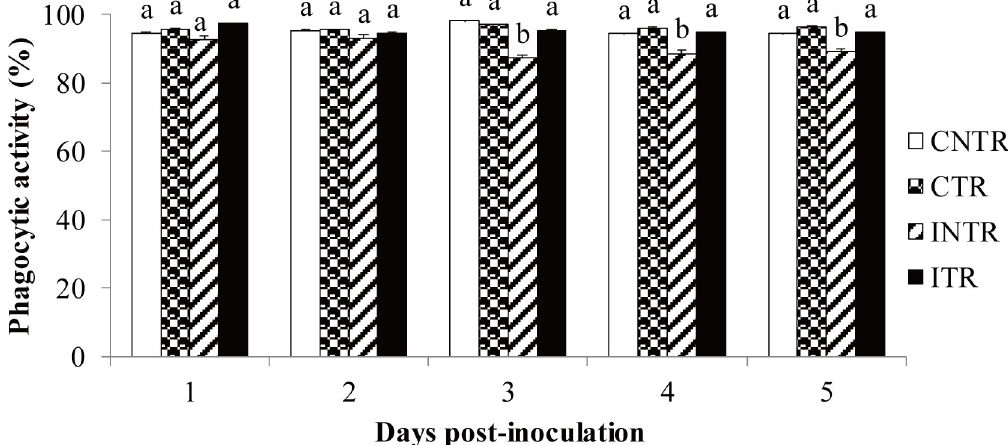
Fig 9. In vivo phagocytosis. In vivo phagocytic activity of Locusta migratoria manilensis inoculated with Beauveria bassiana (3 × 10 5 spores/5 th instar nymph) and injected with FITC-labelled silica beads at various days post-infection. CNTR means control non-thermoregulating insects; CTR, control thermoregulating insects; INTR, infected non-thermoregulating insects; and ITR, infected thermoregulating insects. Data are given as percentages (means ± SE). 8–10 insects were used per treatment and per interval. Different letters indicate significant